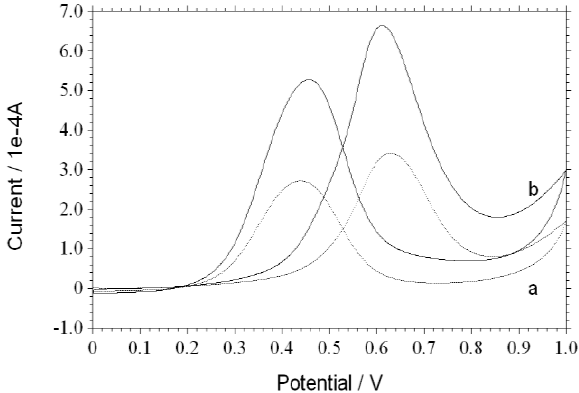
Figure 4. CV curves of Pt/ND ( a ) and Pt/ZrO 2 /ND ( b ) electrodes in 0.5 mol/L CH 3 OH + 0.5 mol/L H 2 SO 4 .